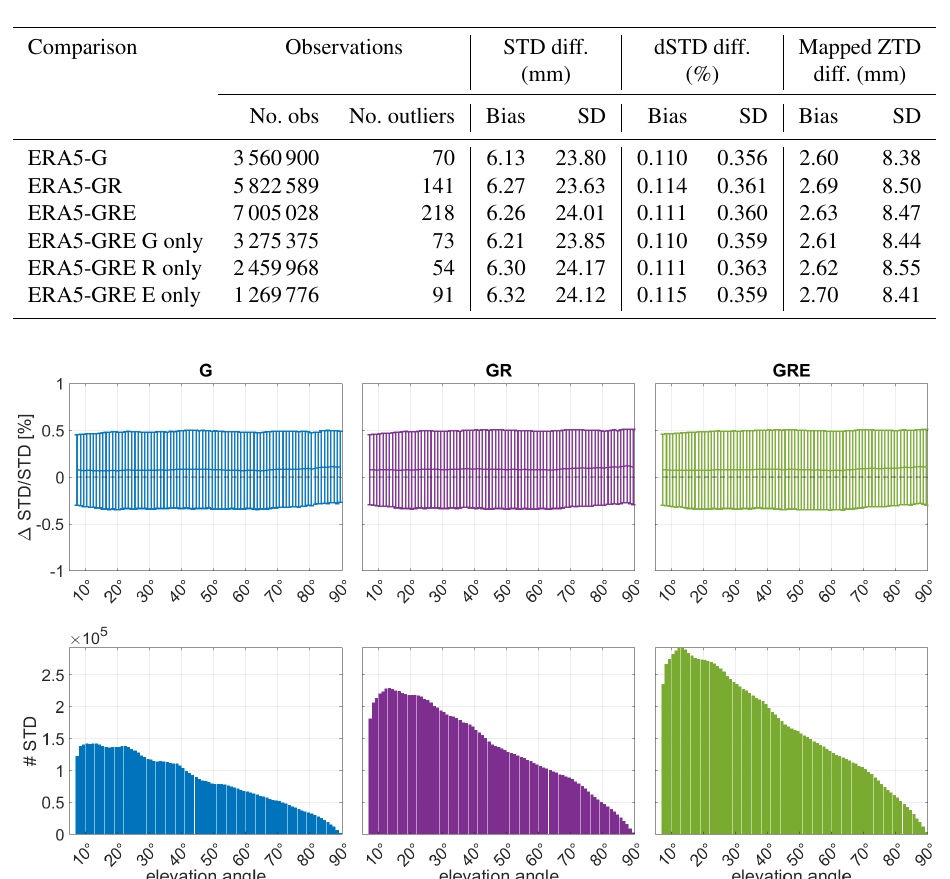
Table 9. The STD biases and standard deviations between ERA5 and different GNSS solutions (for Germany: 313 stations). The statistics are calculated four times per day (at 00:00, 06:00, 12:00, and 18:00UTC) and averaged over the year 2020.